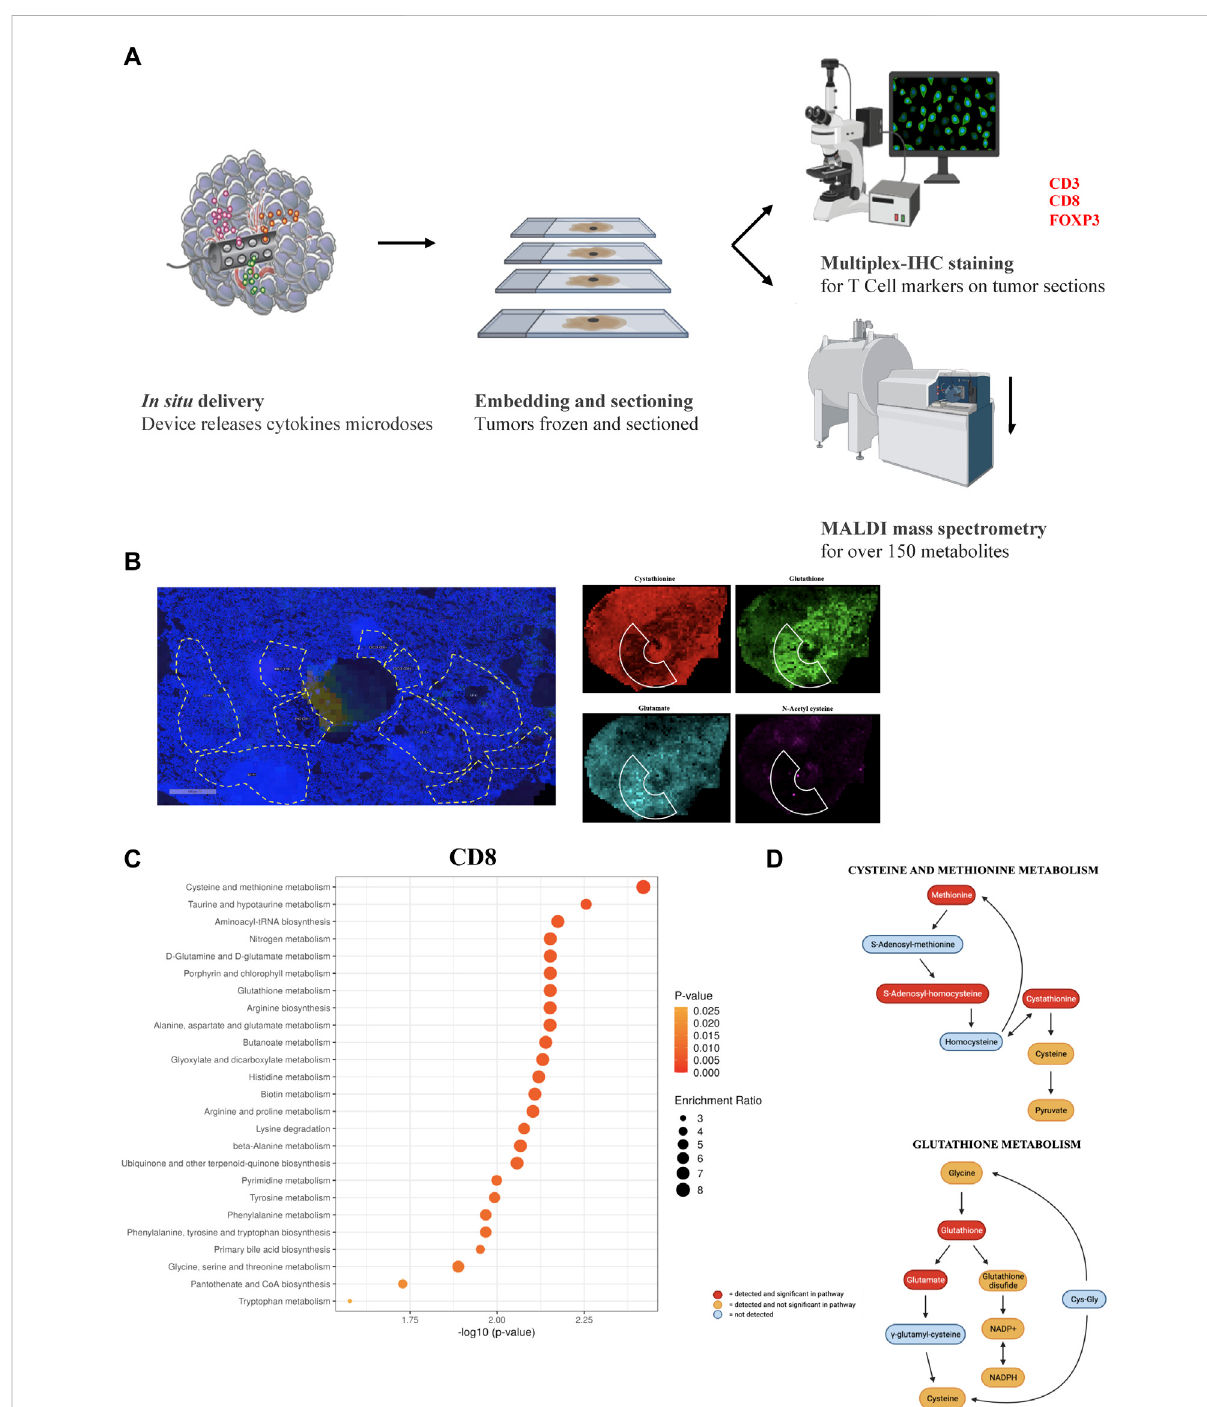
FIGURE 4 (A) Schematic representation for the unbiased metabolomics experiment. (B) Representative images showing the ROIs selection and metabolite quanti fi cation. (C) Top 25 most signi fi cant pathways enriched comparing CD8 high vs. CD8 low ROIs. (D) Statistical signi fi cance of single metabolites in the Cysteine and Methionine Metabolism and Glutathione Metabolism pathways (signi fi cant values have p <